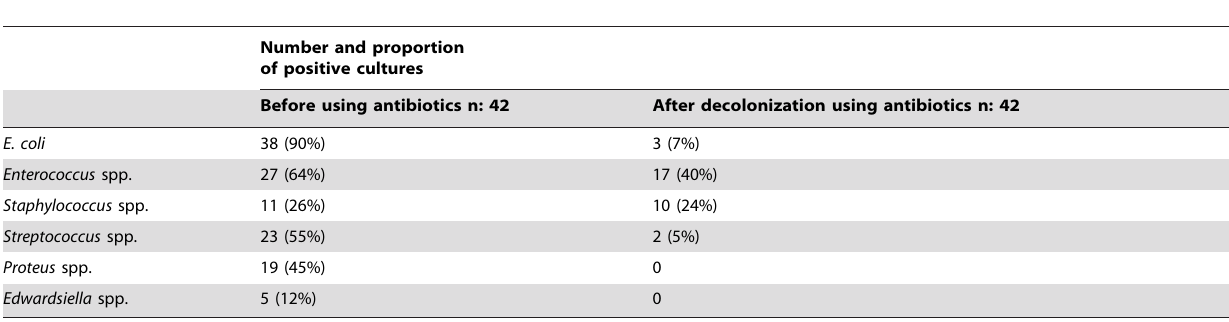
Table 2. Microbiological results of stool culture obtained from rats before and after decolonization with antibiotics (vancomycin and ceftriaxone).